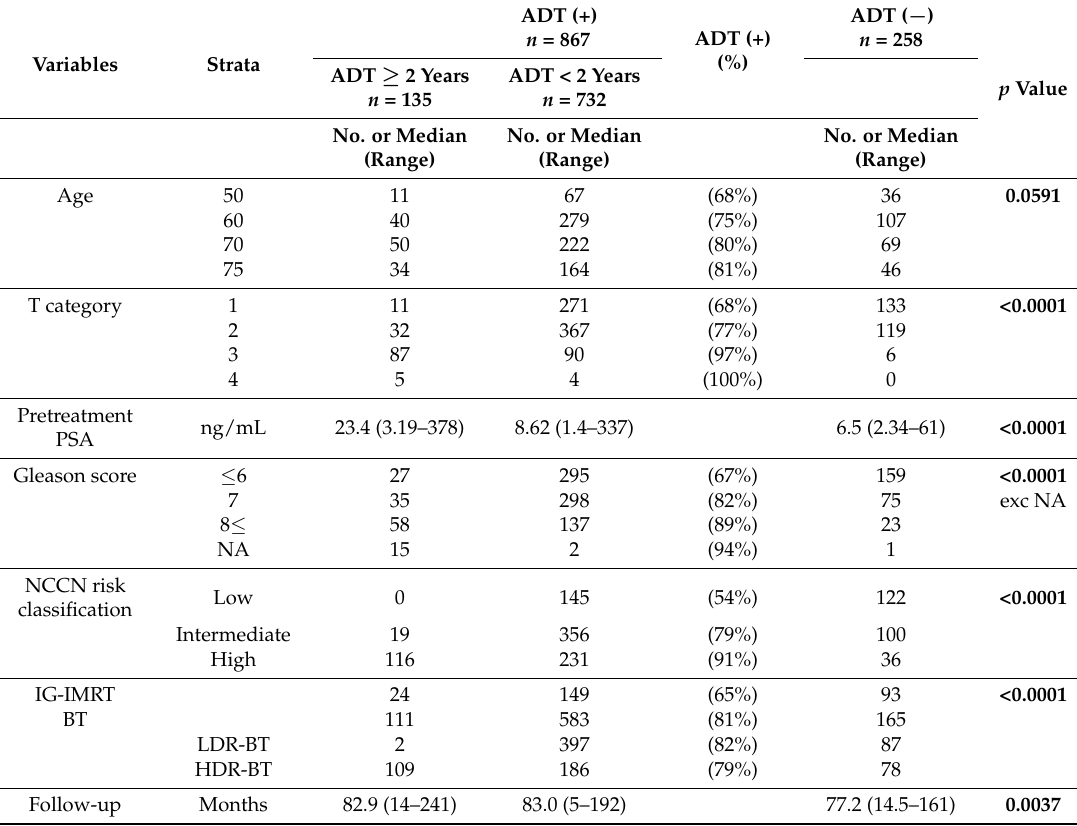
Table 1. Characteristics and treatment factors of patients according to androgen deprivation therapy